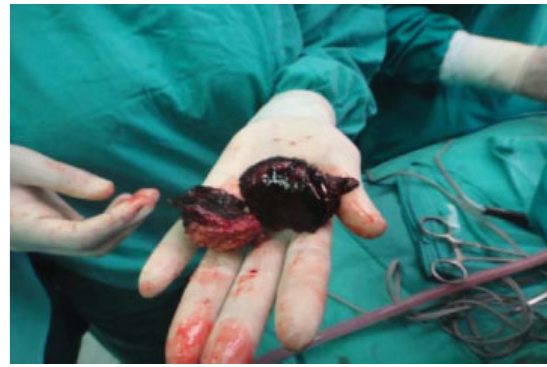
Fig. 3 The deroofed cyst containing